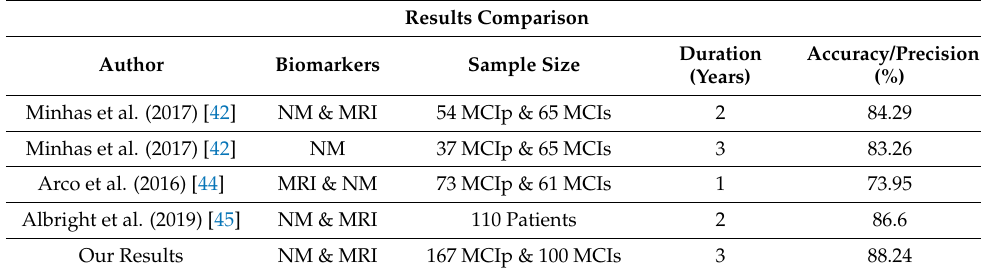
Table 3. A comparison of results between existing techniques.